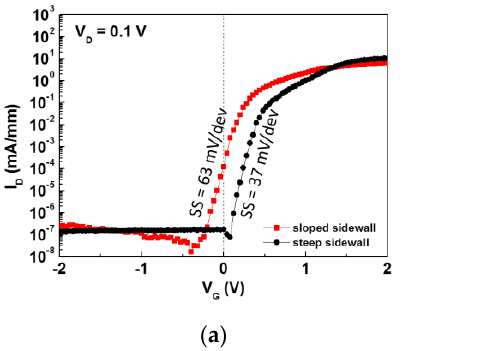
Figure 3. ( a ) Logarithmic transfer curves of sloped sidewall FinFETs (red line) in this work and steep sidewall FinFETs (black line) in our previous work; ( b ) Transfer curves of the two devices in (a). The schematic images of sloped and steep sidewall fin structures are shown in the insert of (b). Table 2. Key parameters for each device exhibited in Figure 3.